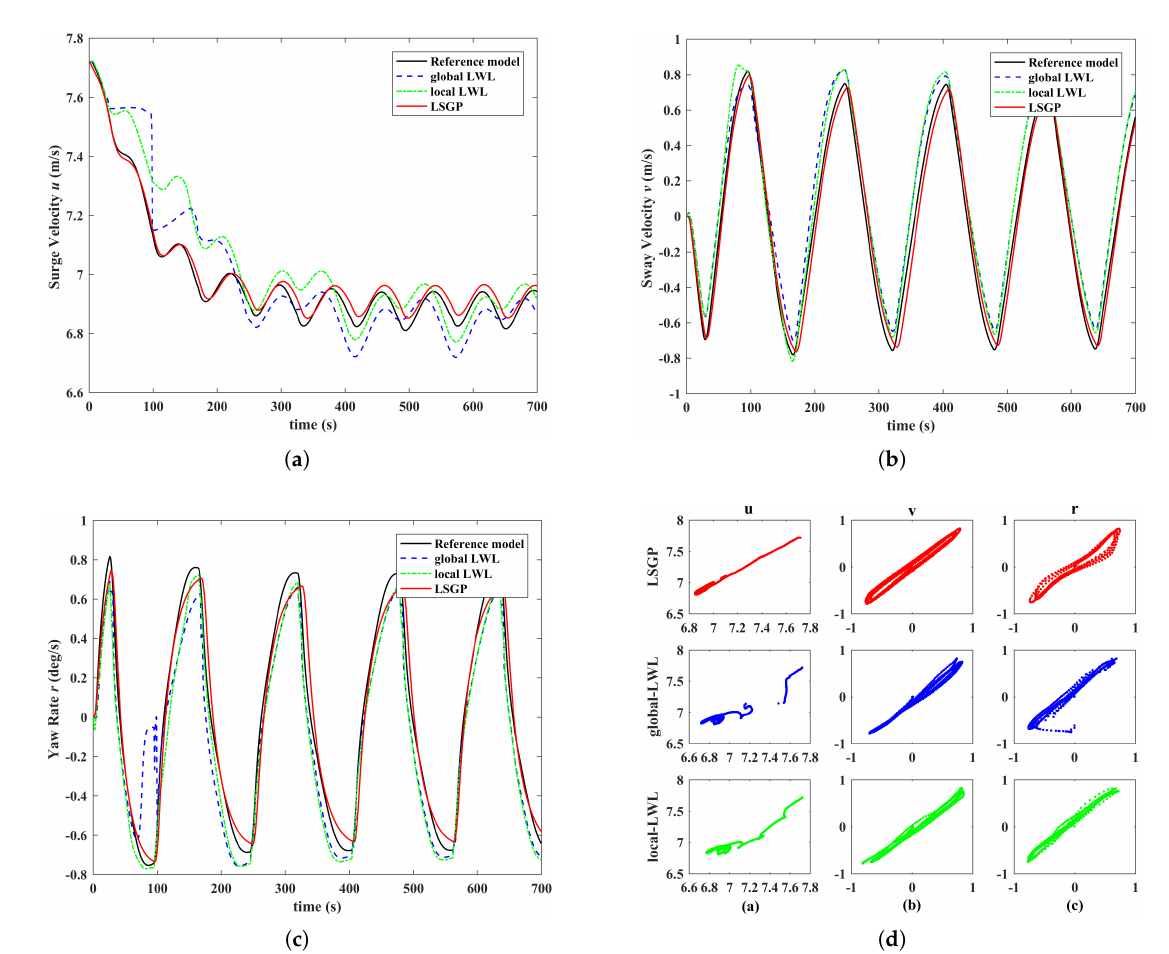
Figure 7. Comparison results of ship motion states for the simulated ZZ-20 ◦ -10 ◦ test. It shows the changes of the ship’s motion state on the three degrees of freedom, ( a ) is the Surge Velocity, ( b ) is the Sway Velocity, and ( c ) is the Yaw rate. ( d ) Scatter plot of simulation prediction and reference model, the abscissa is simulation prediction, and the ordinate is reference model in each sub-figure.